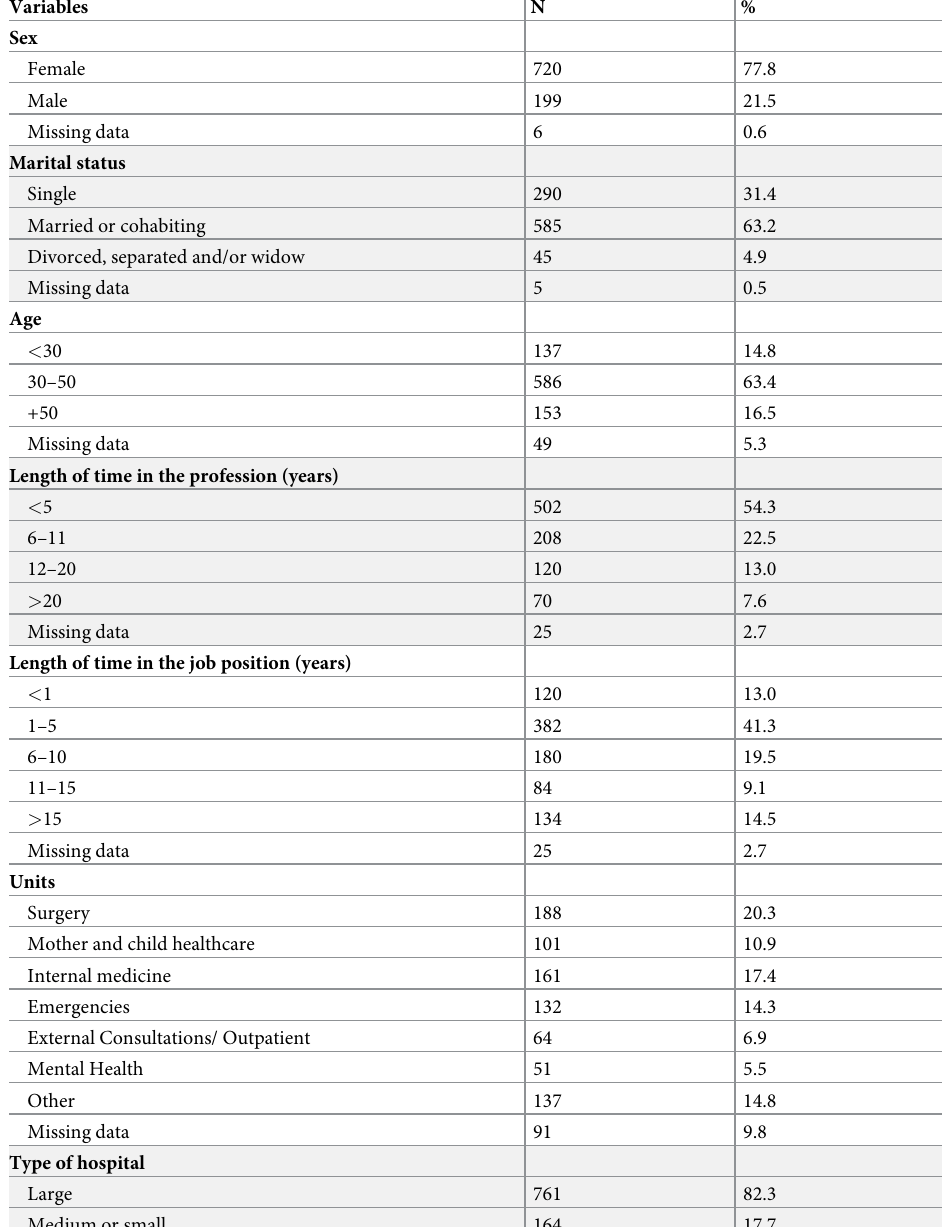
Table 1. Sociodemographic and work-related